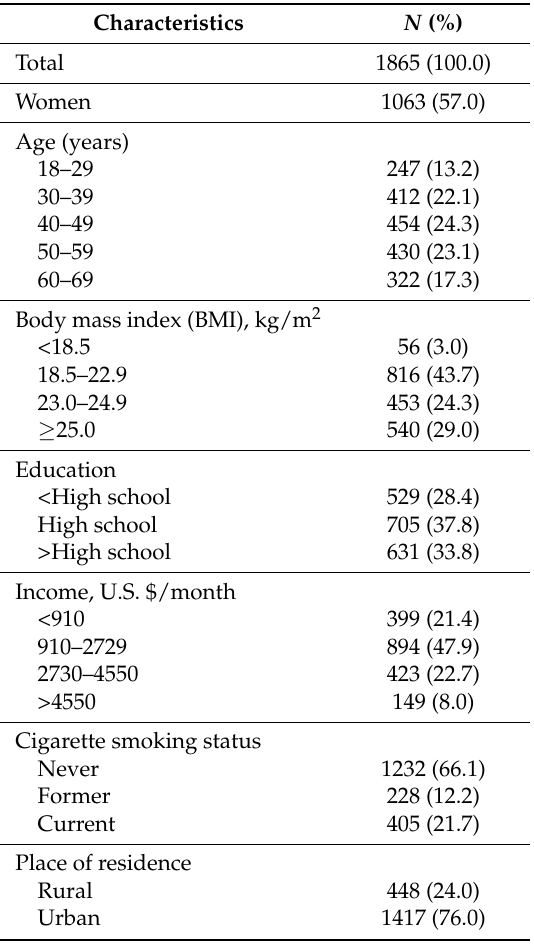
Table 1. General characteristics of study participants.